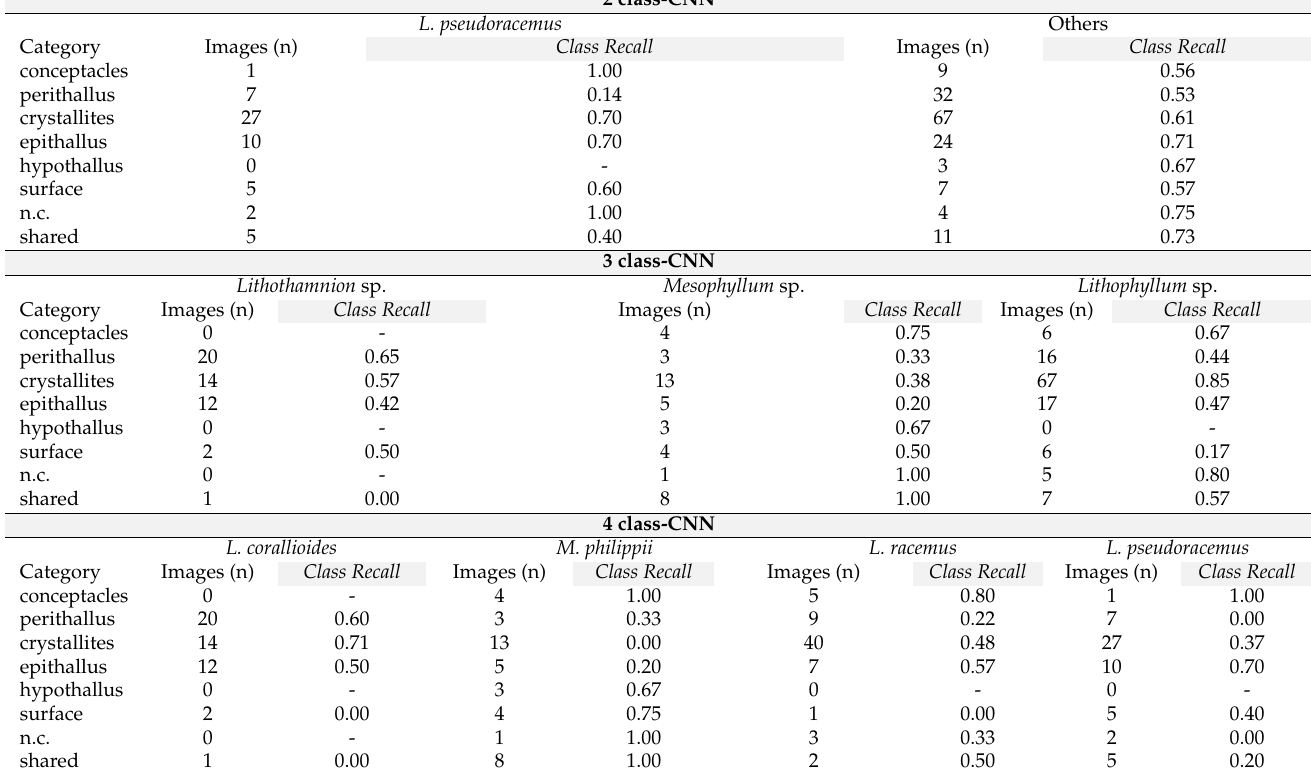
Table 3. The total number of SEM images in each class (columns) and categories (rows) according to the three modeling approaches ( L. pseudoracemus versus other species, diverse genera, and diverse species) is listed, together with the Class Recall . Images not assigned to a category (n.c.) and showing more than one category (shared) are also included. 2 class-CNN L.